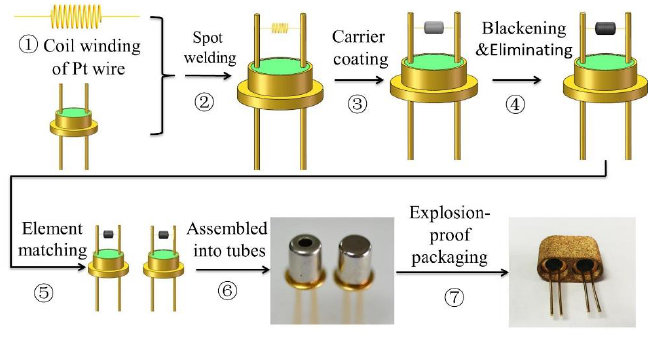
Figure 2. The manufacturing process of the sensor has seven main steps.